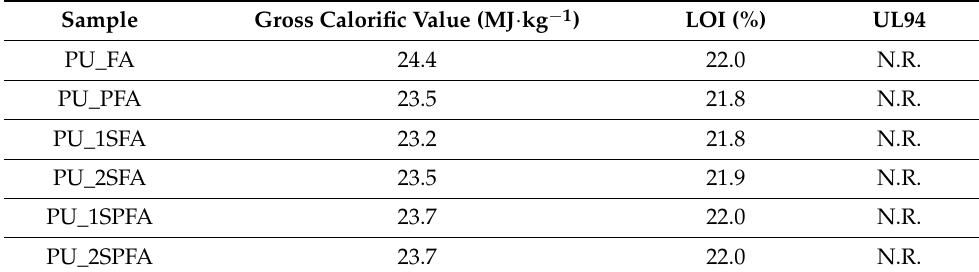
Table 5. Gross calorific value, LOI values, UL-94 vertical burning behaviors of polyurethane com- posites.